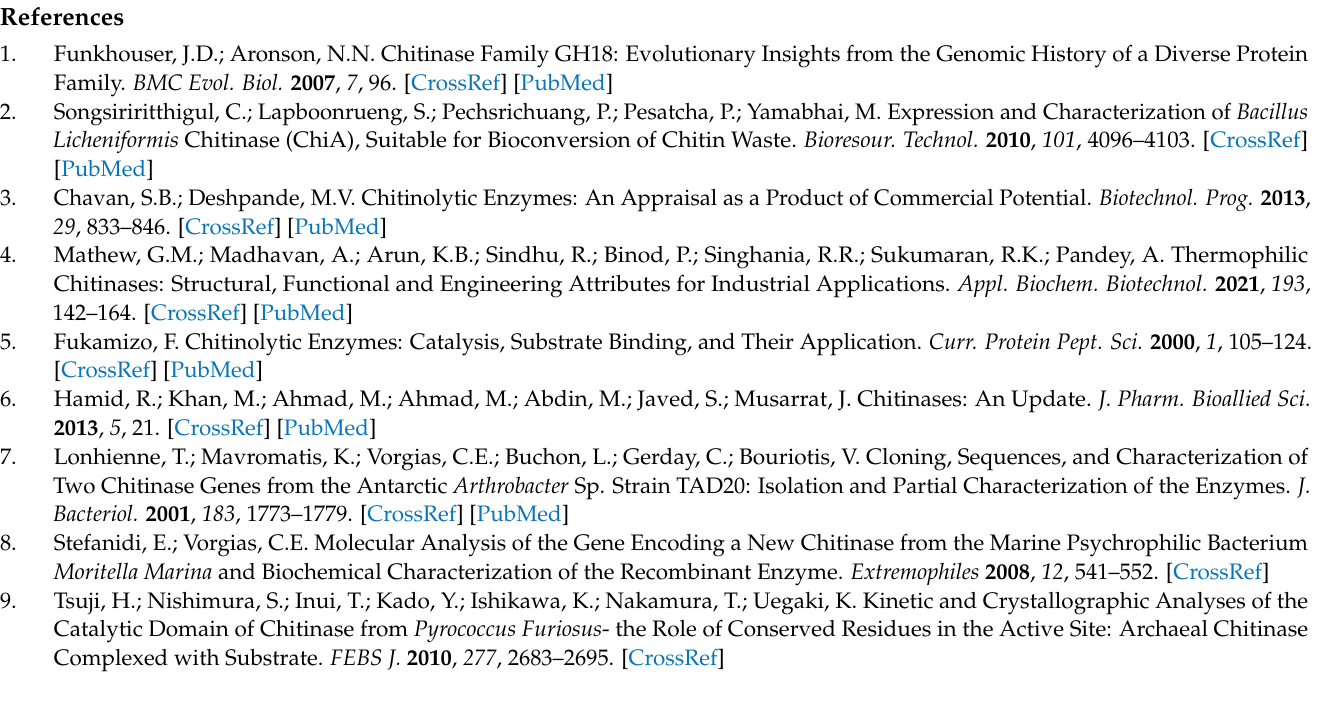
thermally adapted chitinases; Table S2: Summary of the active site and identified loop sequences; Figure S1: Secondary structure analysis; Figure S2: Root-mean-square deviation (RMSD), solvent- accessible surface area (SASA), and radius of gyration plots; Figure S3: Root-mean-square fluctuations (RMSF) plots with key loops and active sites; Figure S4: RMSD of all identified loops and active sites; Figure S5: Frames extracted from 400 K molecular dynamics (MD)